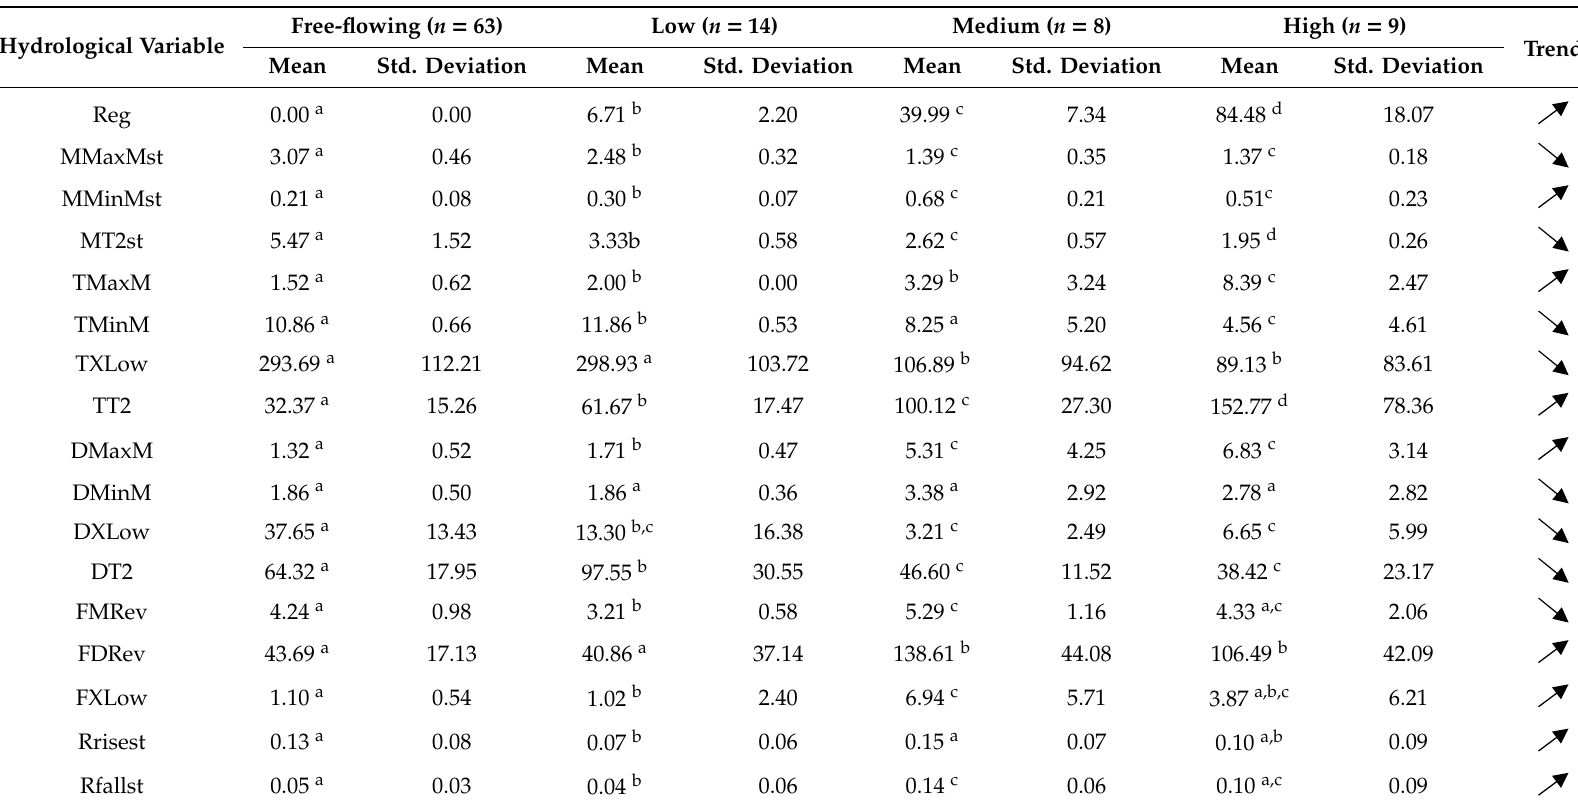
Table 1. Mean and standard deviation of the hydrological variables characterizing each flow regulation group. “ n ” indicates the number of sites included within each flow regulation group. Letters “a,” “b,” “c,” and “d” identify significant differences between groups ( p < 0.05), while the trend across groups is indicated with an arrow. Table 1 footer: Reg: percentage of regulation (%); MMaxMst, MMinMst, and MT2st: magnitude of maximum monthly flow, minimum monthly flow, and 2-year recurrence flow (standardized to the mean annual flow; unitless), respectively; TMaxM and TMinM: timing of the maximum and minimum monthly flows, respectively (being 1 May and 12 April). TXLow and TT2: timing of the extreme low flows and of 2-year recurrence flow (Julian days); DMaxM and DMinM: duration of the maximum and minimum monthly flows, respectively (#months). DXLow and DT2: duration of extreme low flow conditions and of 2-year recurrence flow events (#days); FMRev, FDRev, and FXLow: frequency of the monthly flow reversals, daily flow reversals, and extreme low flows (# per year), respectively; Rrisest and Rfallst: daily rate of flow rise and fall, respectively (standardized to the mean annual flow; unitless). Further details on hydrological variables are available in Annex 1.